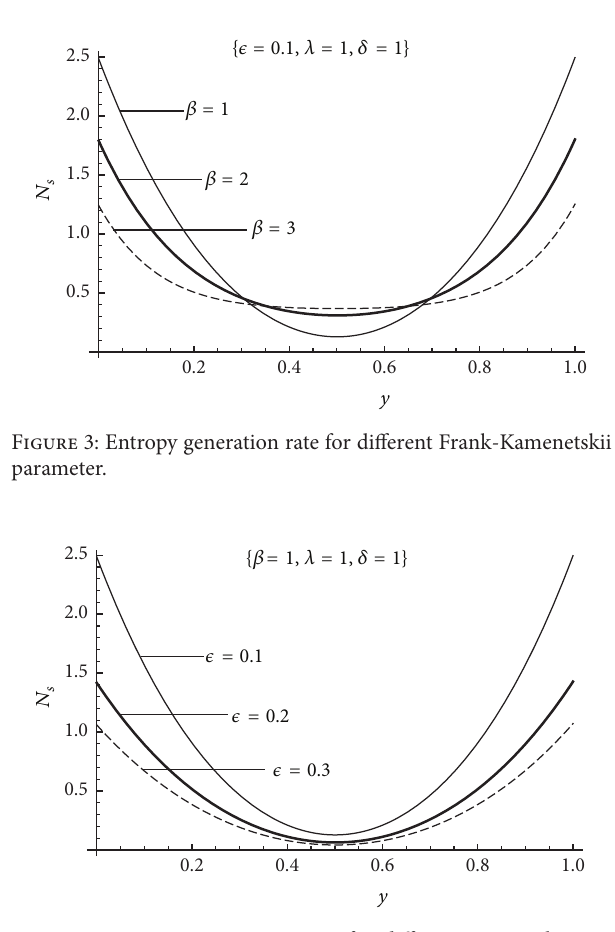
Figure 4: Entropy generation rate for different viscous heating parameter.